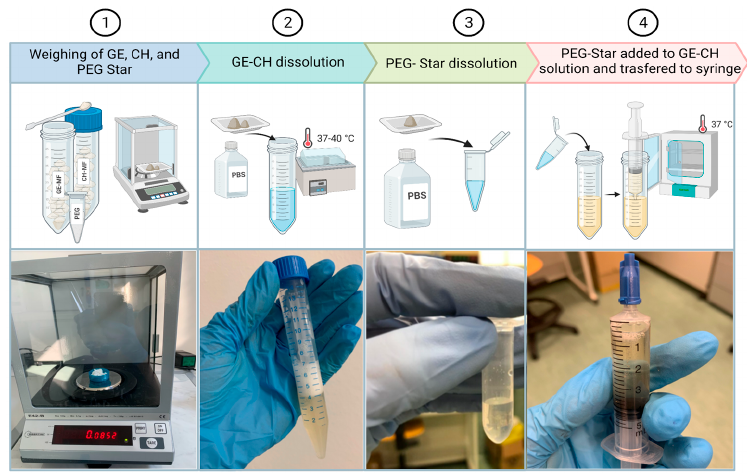
Figure 7. Hybrid-hydrogel preparation. The process started with ( 1 ) the freeze-dried materials, which were weighted according to the protocol. Subsequently, ( 2 ) gelatin (GE) and chitosan (CH) were dissolved in PBS, ( 3 ) the weighted Star-PEG-MA was also dissolved in its PBS aliquot, and, finally, ( 4 ) the two solutions were combined, transferred into a syringe, and placed in an incubator at 37 °C until completely cross-linked.